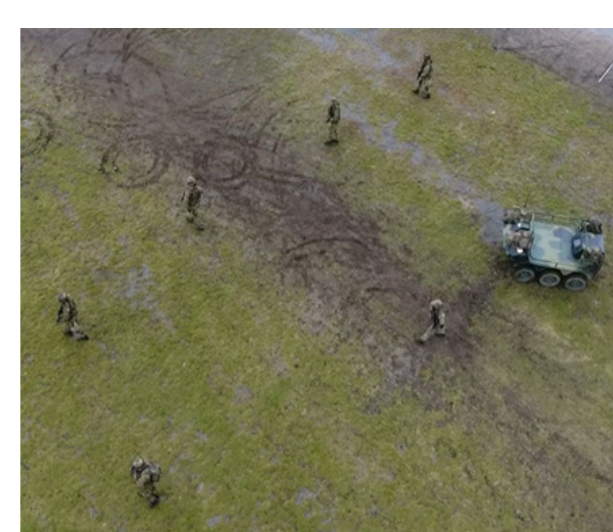
Figure 4 – Assault team movement supported by the TAROS. The image taken by the drone controlled by the team